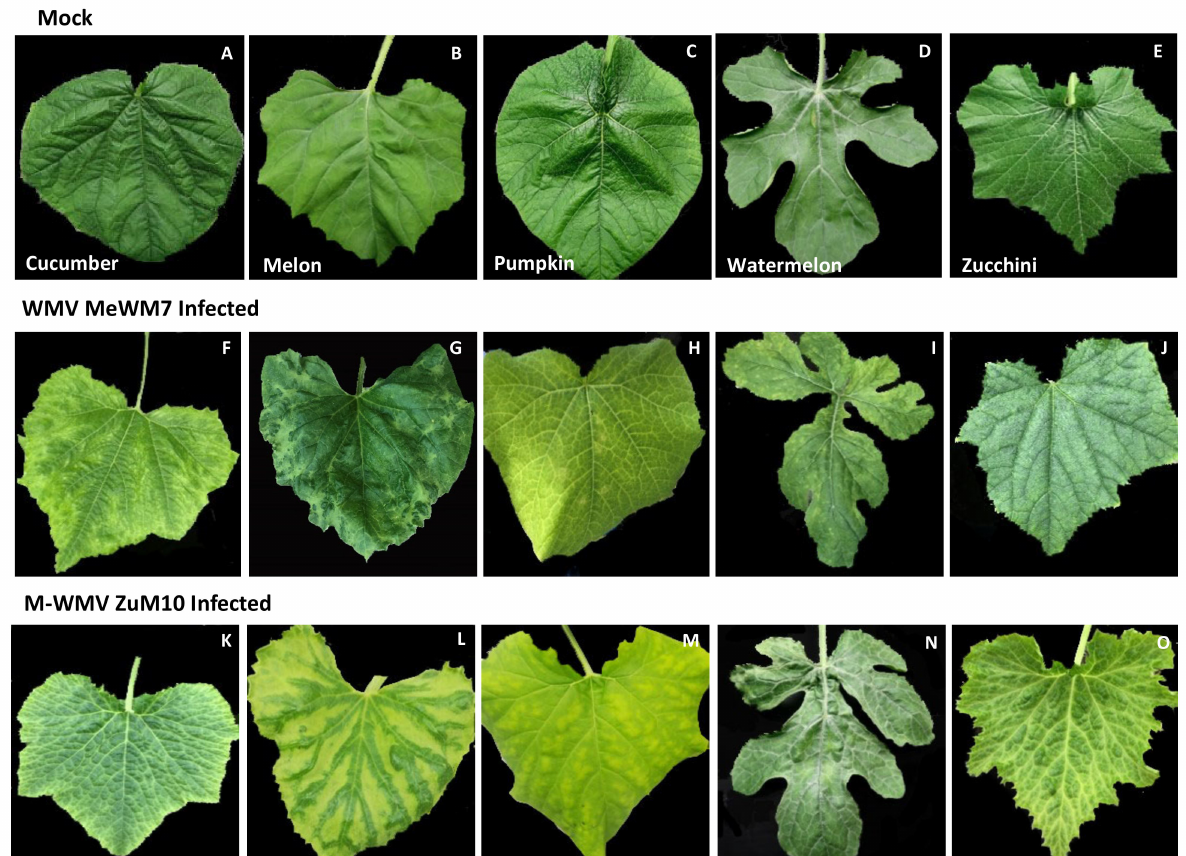
Figure 3. Symptom expressions of the agro-inoculated cucumber ( F , K ), melon ( G , L ), pumpkin ( H , M ), watermelon ( I , N ), and zucchini ( J , O ) plants with the WMV-MeWM7 and MWMV-ZuM10 clones, respectively. Mock plants ( A – E ). All plants were cultivated under experimental conditions in a greenhouse at 24 ◦ C for 24